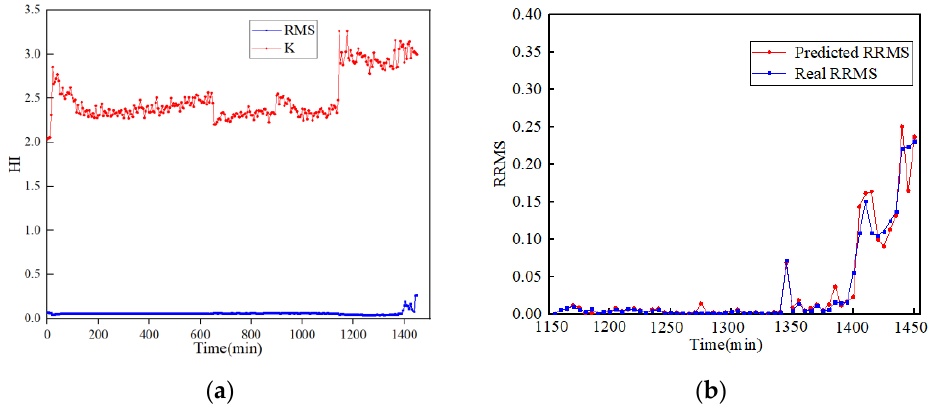
Figure 10. ( a ) Degradation characteristics; ( b ) real RRMS and predicted